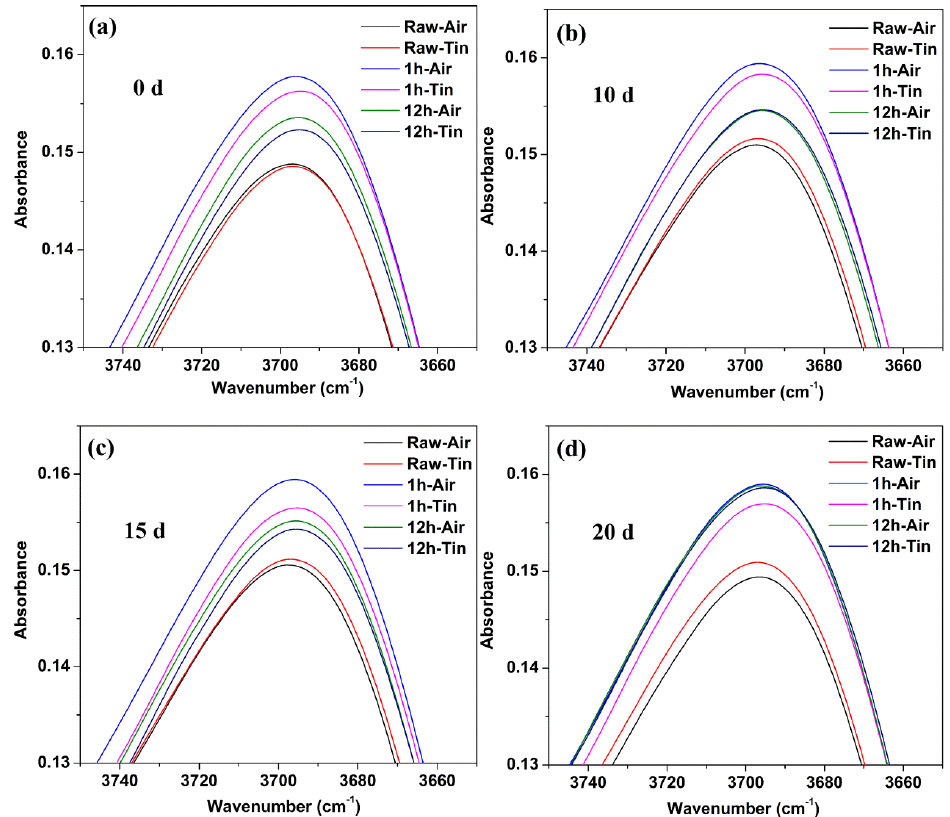
Figure 6. IR spectra at 3697 cm − 1 for the raw glass and ion-exchanged glasses with different immersion times: ( a ) 0 d; ( b ) 10 d; ( c ) 15 d; ( d ) 20 d.